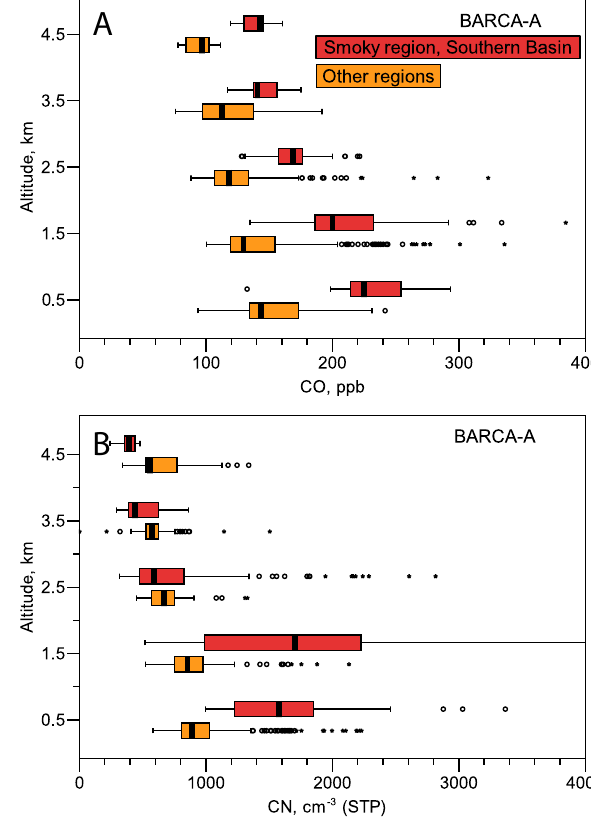
Fig. 5. Latitudinal (A) and longitudinal (B) distribution of CO dur- ing the BARCA campaigns, based on 1-min averages of the in- situ measurements. Simultaneous measurements taken at the NOAA ESRL stations (RPB, ABP, and RPB) and the ground stations MXR and SAN are also shown. In (B) , the longitudinal distance from the coast is calculated as the difference in longitude between the sam- pling location and a line connecting the MXR site with Paramaribo, Suriname, which approximates the position of the coastline.